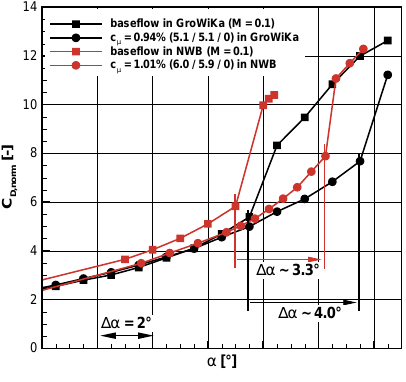
Figure 5. Comparison of results obtained in the GroWiKa wind tunnel [18] and the NWB wind tunnel at M = 0.1.